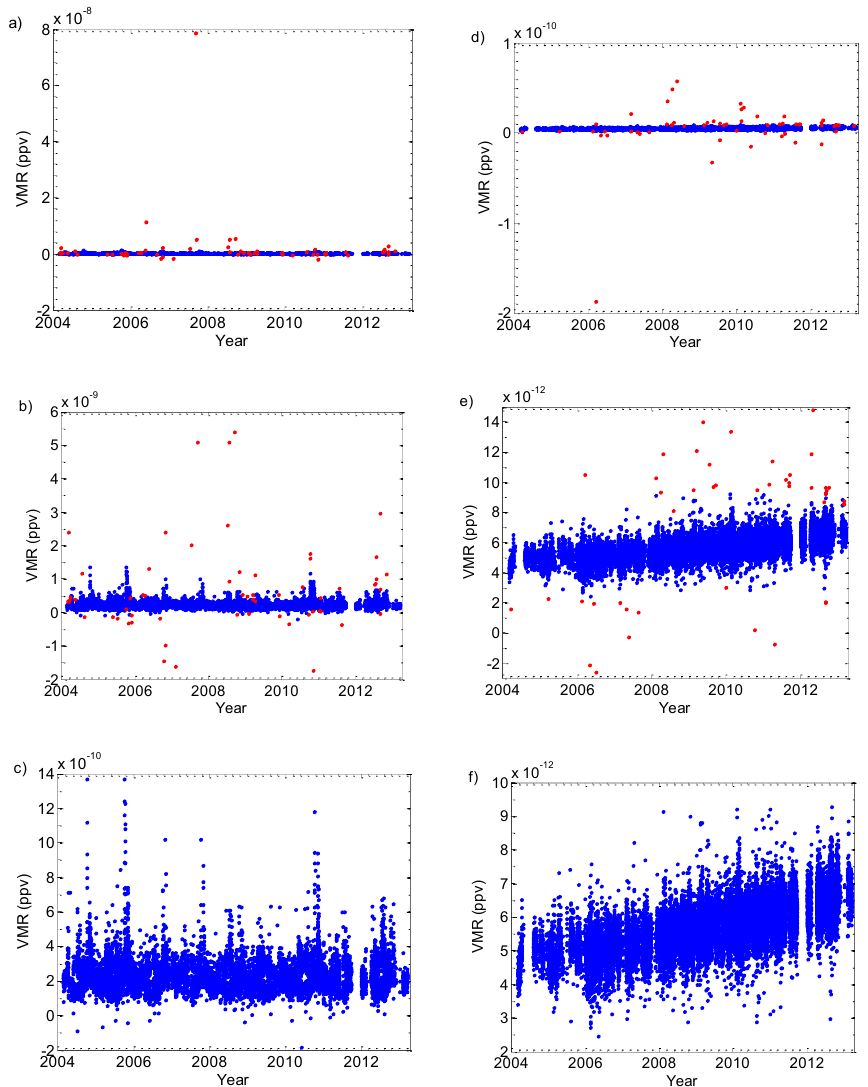
Figure 8. The final inlying data (blue dots) and unnatural outliers (red dots) for all ACE-FTS HCN data at 9.5km (left) and SF 6 data at 19.5km (right). The top panel shows all data, the middle panel is the same as the top panel but zoomed in for clarity, and the bottom panel is all data, excluding the unnatural